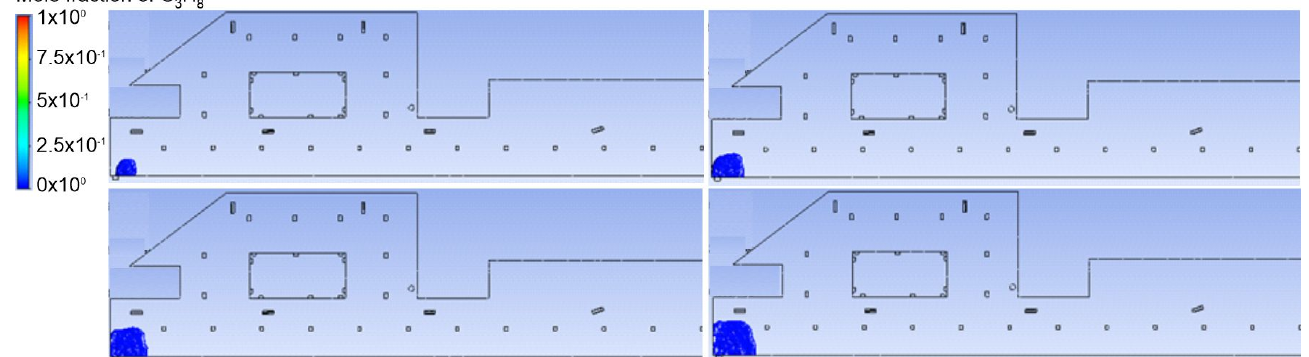
Figure 13. Lower explosive limit of LPG distribution in an underground garage after gas dispersion for A source for different time steps of 2.5 s, 5 s, 7.5 s and 10 s.